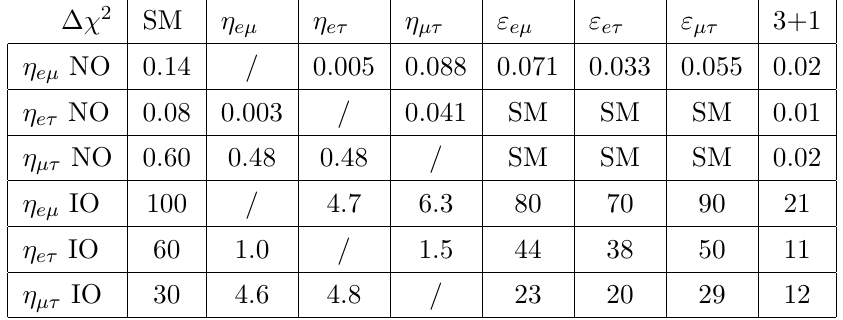
Table 4 . Same as table 3 but with true values set to the best fits of scalar NSI.